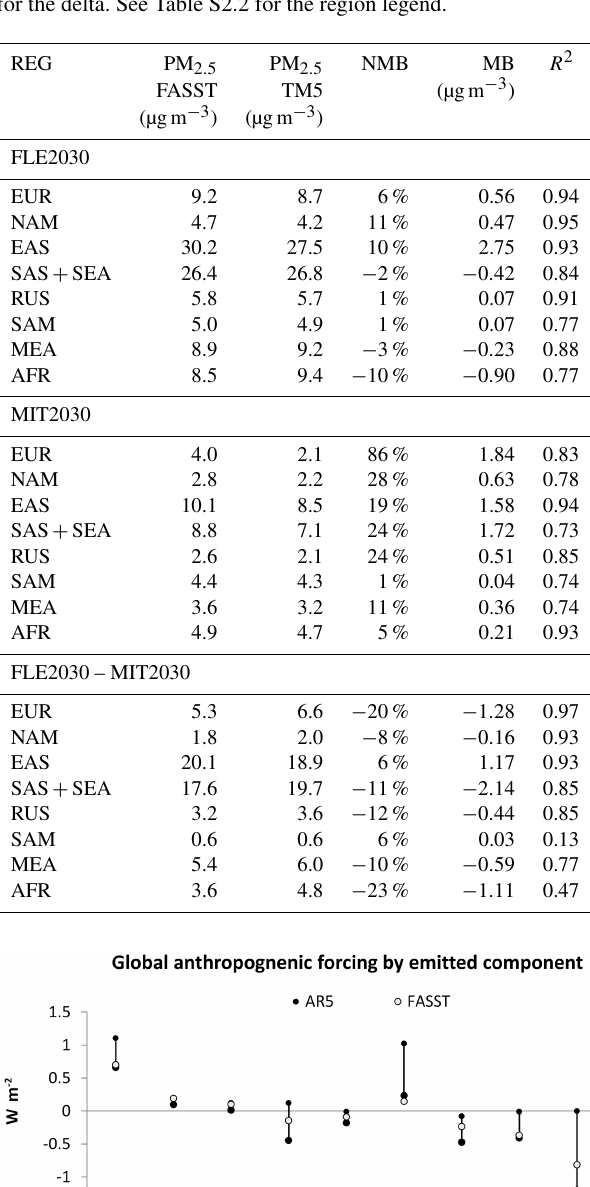
Table 9. Regional grid cell mean anthropogenic ozone health exposure metric 6mDMA1 and performance statistics for FASST versus TM5, for the high-emission (FLE2030) and low- emission (MIT2030) scenarios, and for the delta. See Table S2.2 for the region